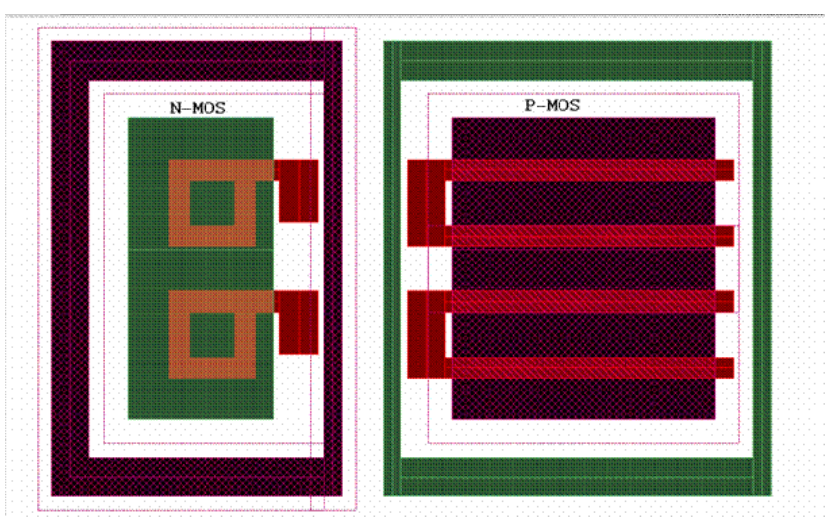
Figure 5. Layout schematic of the radiation tolerant